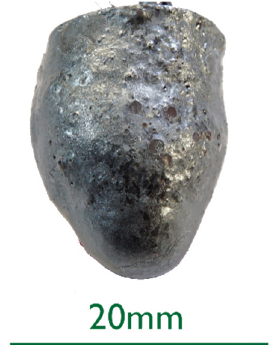
Figure 3. Macroscopic photograph of the sample 0%C-ULC-10s-3.